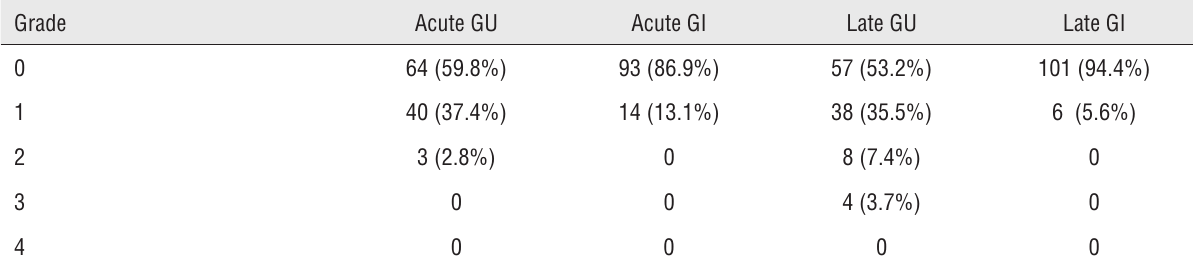
Table-4 - Maximal acute and late gastrointestinal (GI) and genitourinary toxicity according to RTOG criteria. Grade